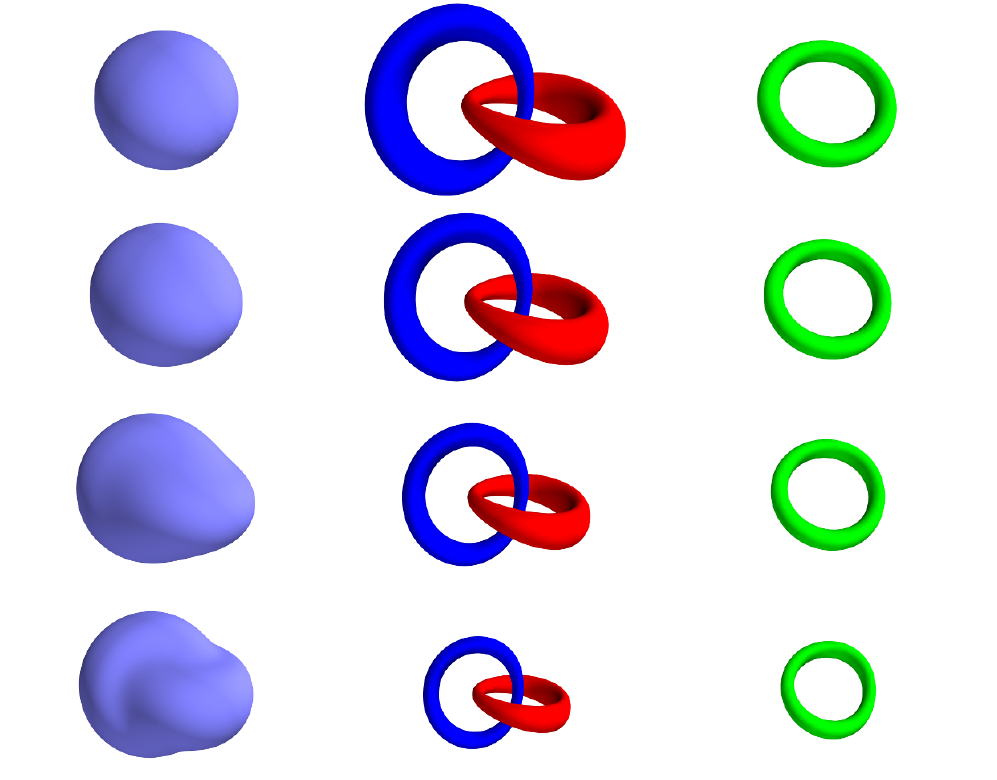
Figure 1 . Isosurfaces showing the energy density distributions ((cid:12)rst column), (cid:30) 1 = (cid:6) 0 : 9 (second column) and (cid:30) 3 = (cid:0) 0 : 9 of the Q = 1 Hop(cid:12)on solutions in the model (2.1) with potential V = m 2 (cid:30) 2 at m = 0 ((cid:12)rst row), m = 1 (second row), m = 2 (third row), m = 4 (fourth row) and c 2 = 1, c 4 = 1. Each plot corresponds to a value of the energy density E = 15 in unrescaled units.